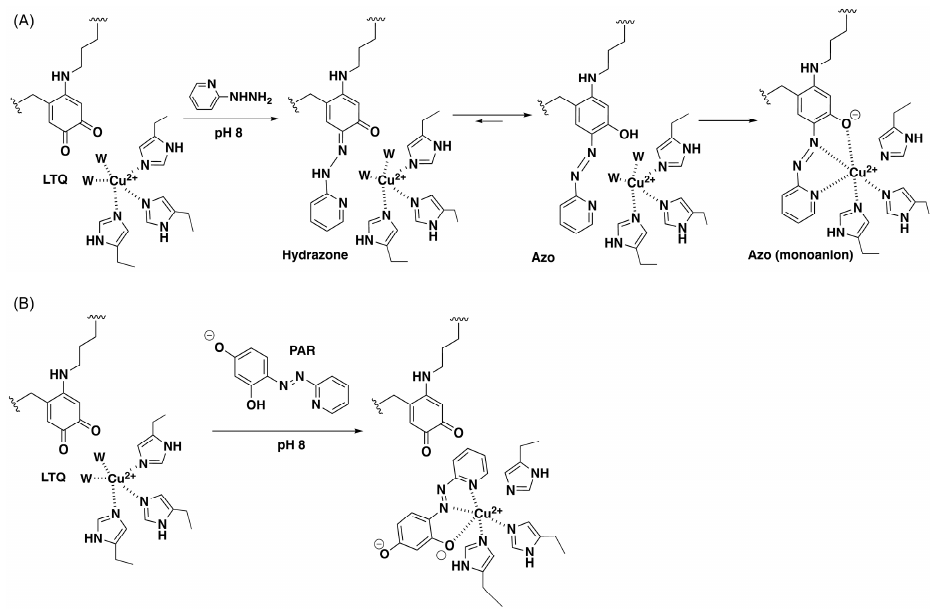
Figure 2. The LTQ cofactor resides within 2.9 Å of the active site Cu 2+ in the catalytically − competent LOXL2 [25]. ( A ) 2HP covalently modifies the C5 carbonyl group of LTQ to form LTQ − 2HP adduct. Ligation of LTQ − 2HP adduct to the active site Cu 2+ through O4 results in the formation of the monoanion form of LTQ − 2HP ( λ max = 531 nm) at pH 8.0. ( B ) The active site Cu 2+ in the mature LOXL2 can be titrated by PAR. W: water ligand to Cu 2+ .